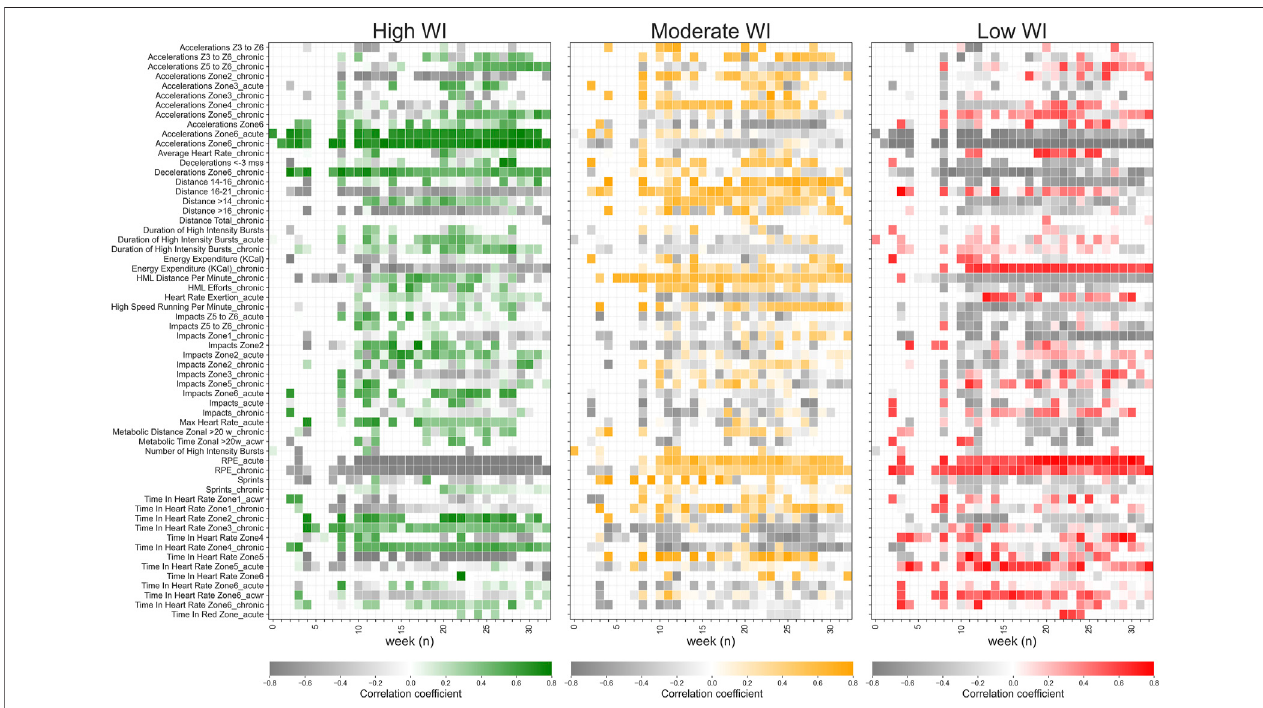
FIGURE 5 | In fl uences of a single variable on belonging to a speci fi c WI class. The values provided show an importance higher than 3%. Coloured bars show a positive in fl uence, i.e., the higher the feature value is the higher is the probability to be in a speci fi c WI class, while vice versa for grey bars.